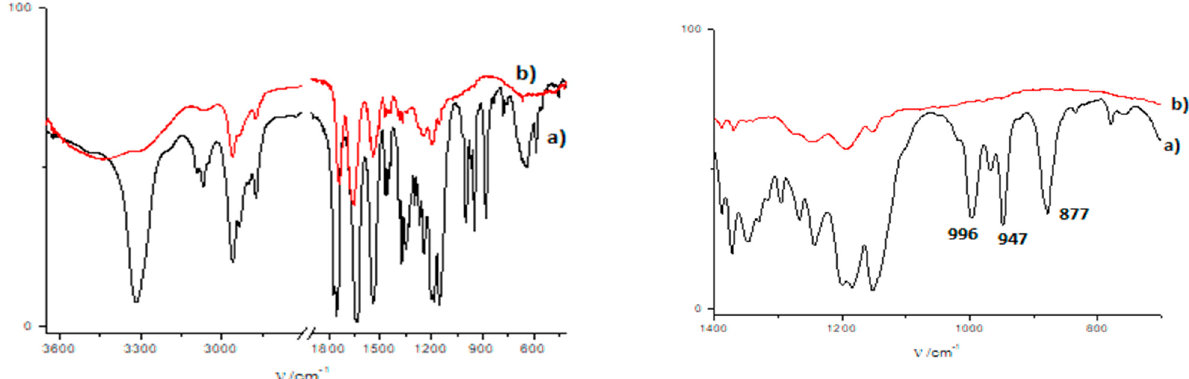
Figure 7. FTIR spectra of 1a (red) and the product of 1a /(DMF-H 2 O gel (black) gamma polymeriza- tion . Total spectra ( left ) and the zoom-in spectra in the range between 1400 and 700 cm − 1 ( right ).